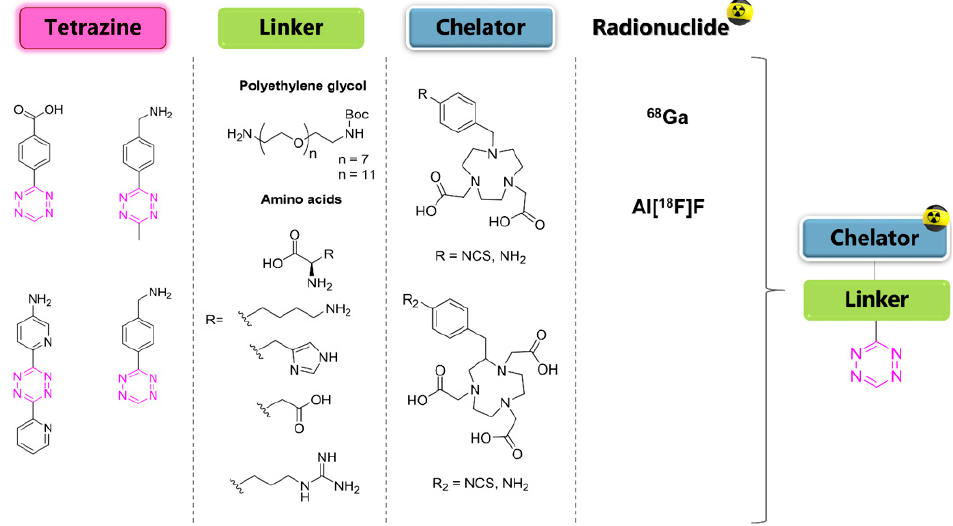
Figure 6. Modular approach for the synthesis of Tzs: Radioligands consisted of a Tz scaffold for in vivo click, a linker to alter the biodistribution, and a chelator to bind the radionuclide.